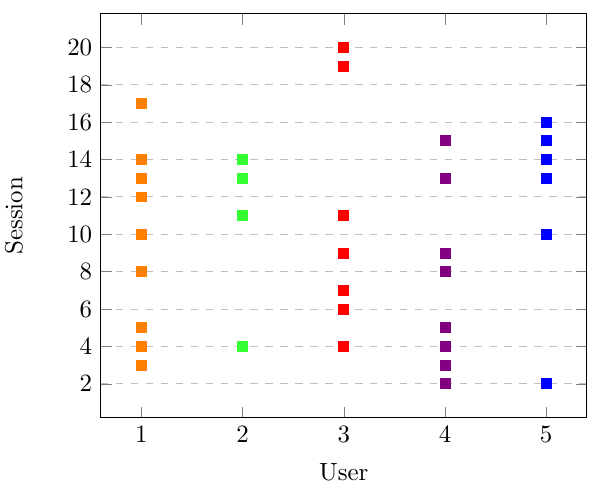
Figure 4. Sessions with significant change in Dataset LGR.